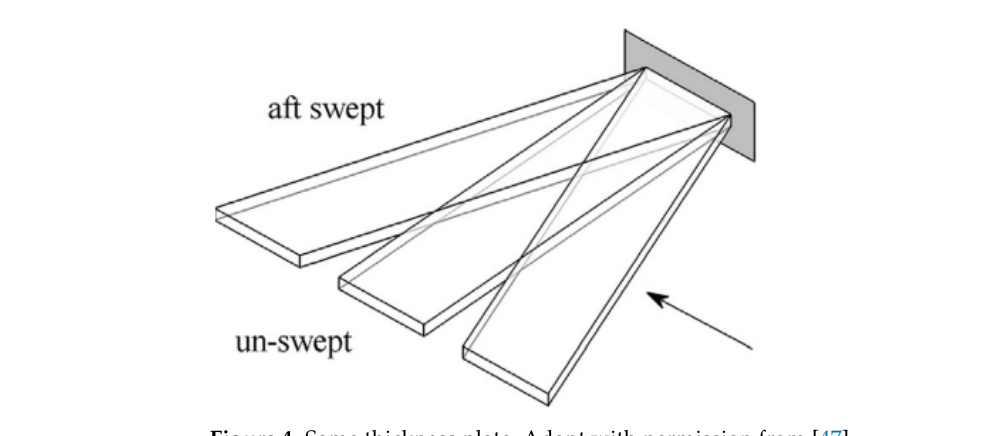
Figure 3. Multi ‐ layer composite plate with delamination, Adapt with permission from [46].